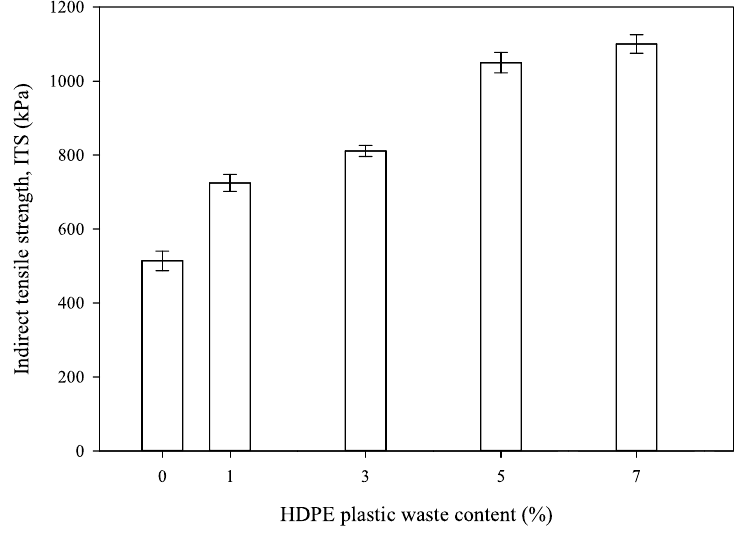
Figure 3. Indirect tensile strength of HDPE-ACP.